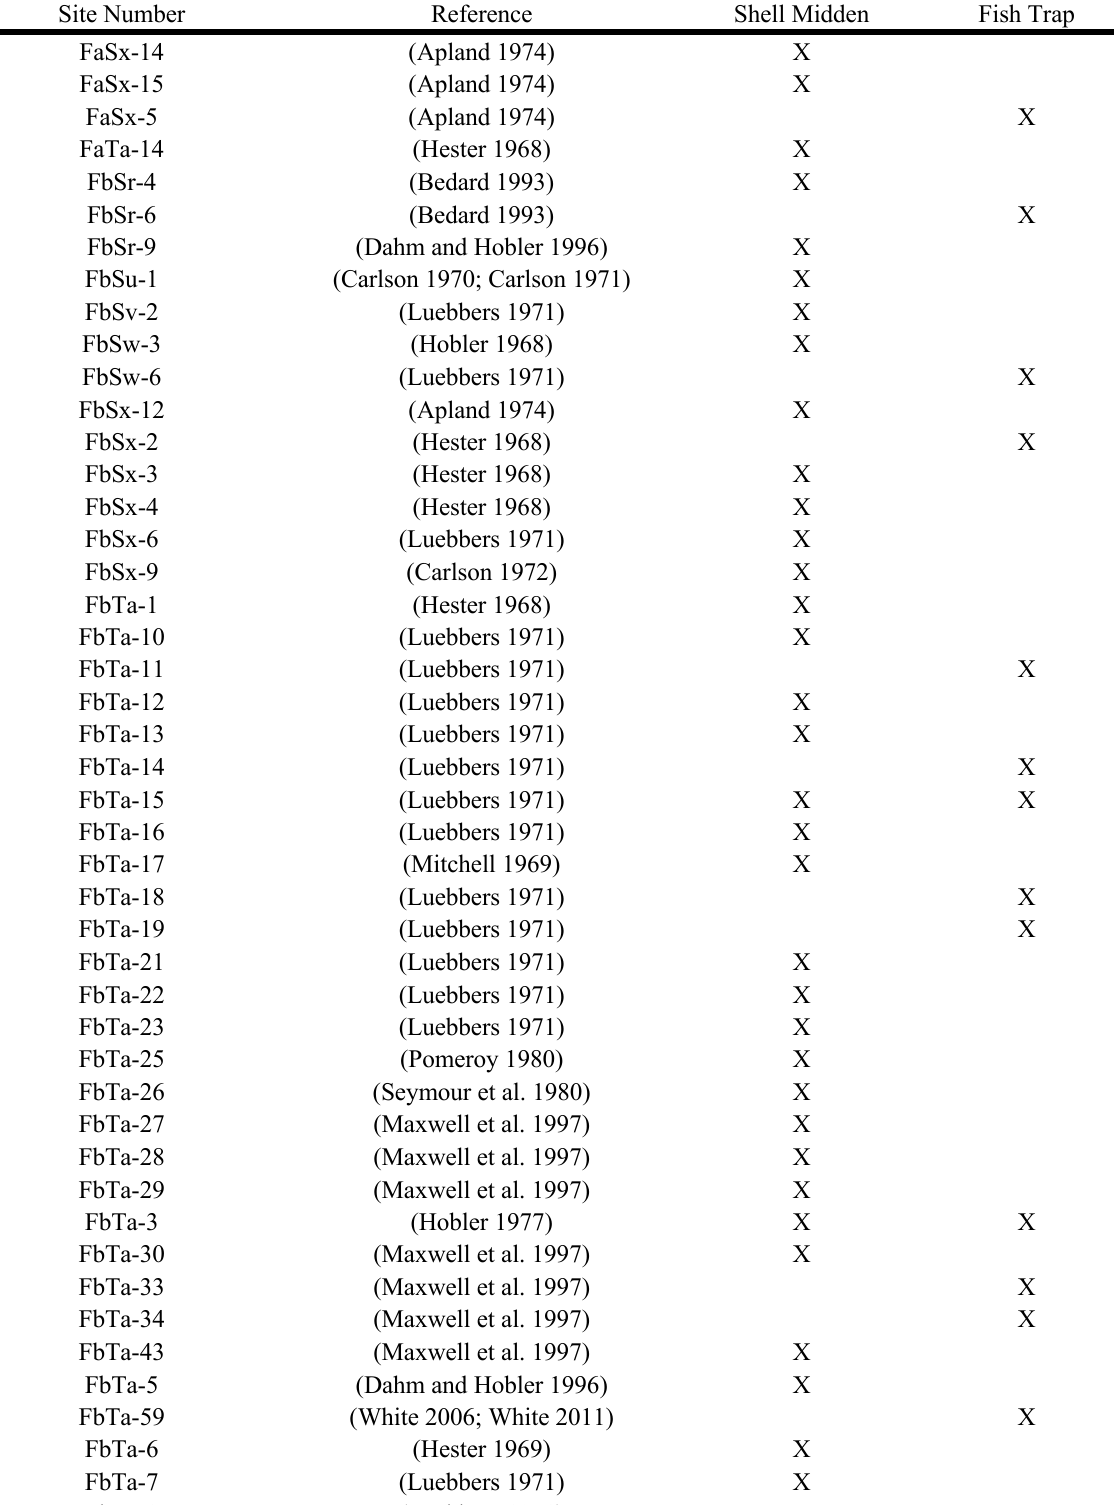
Table A1.2 Primary sources for archaeologically recorded shell middens and fish traps in the study